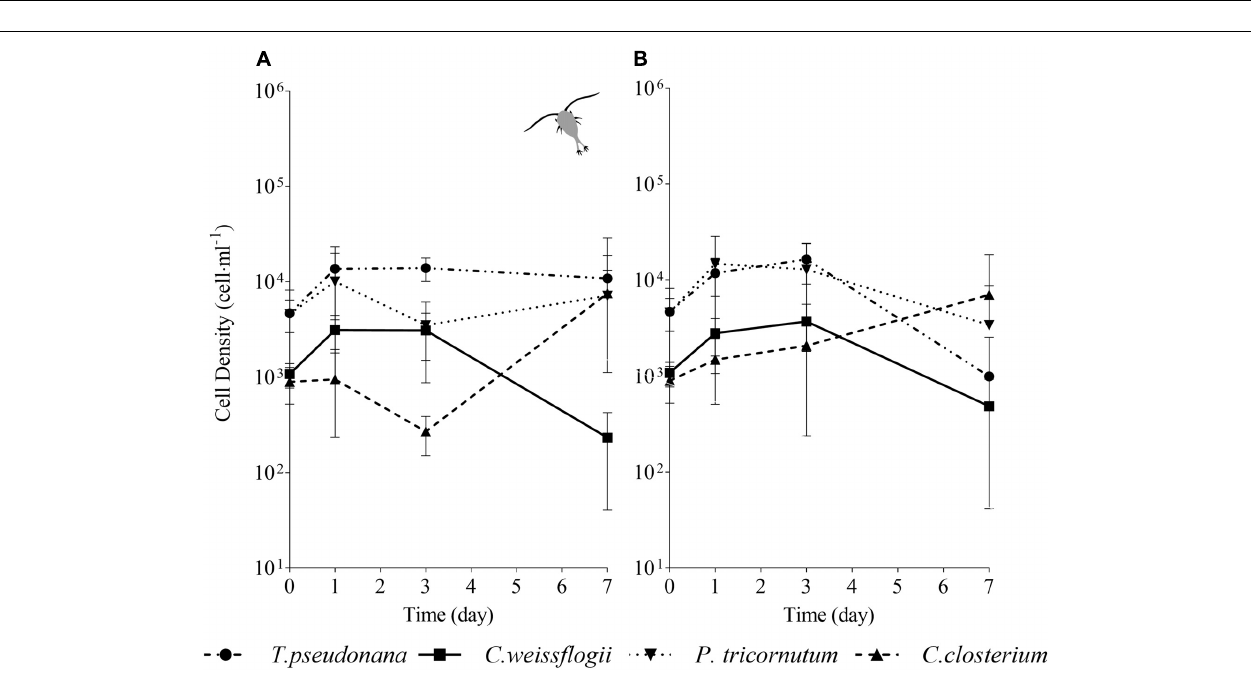
FIGURE 6 | PCA analysis on morphological characteristics in T. pseudonana (A) , C. weissflogii (B) and C. closterium (C) when mixed together. Different symbols indicate different time during the experiment: T0 ◦• ; T1 (cid:3)(cid:4) , T3 (cid:52) (cid:78) , T7 ♦(cid:7) ; white symbols indicate copepods exposure while black symbols indicate absence of copepods and interspecies competition (IC) only.